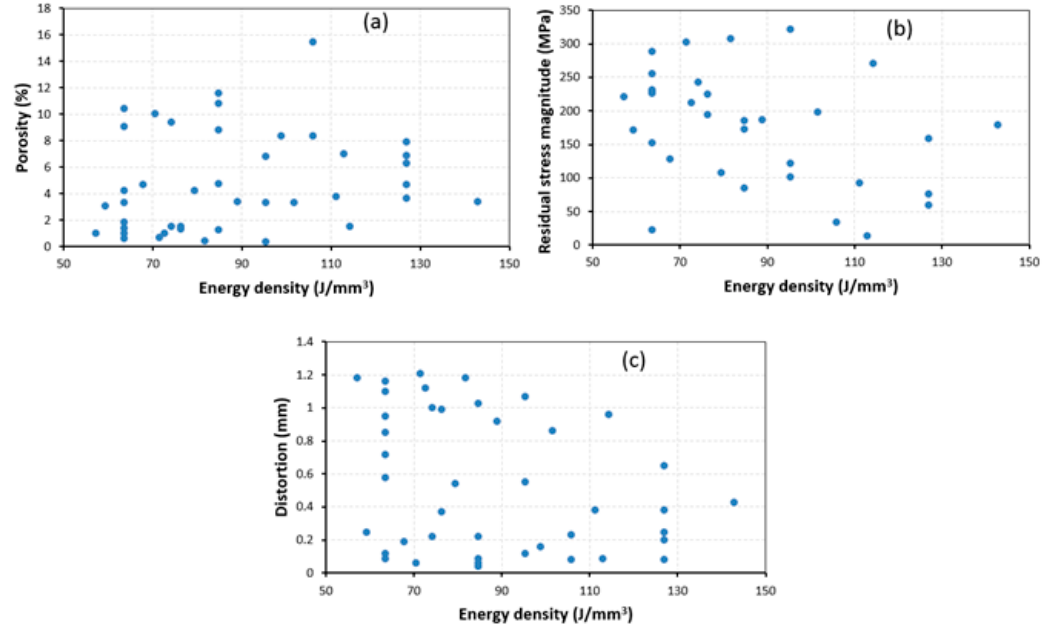
Figure 12. Scatter plots of the e ff ect of energy density on ( a ) porosity, ( b ) residual stress magnitude, and ( c ) distortions for the layer thicknesses studied.